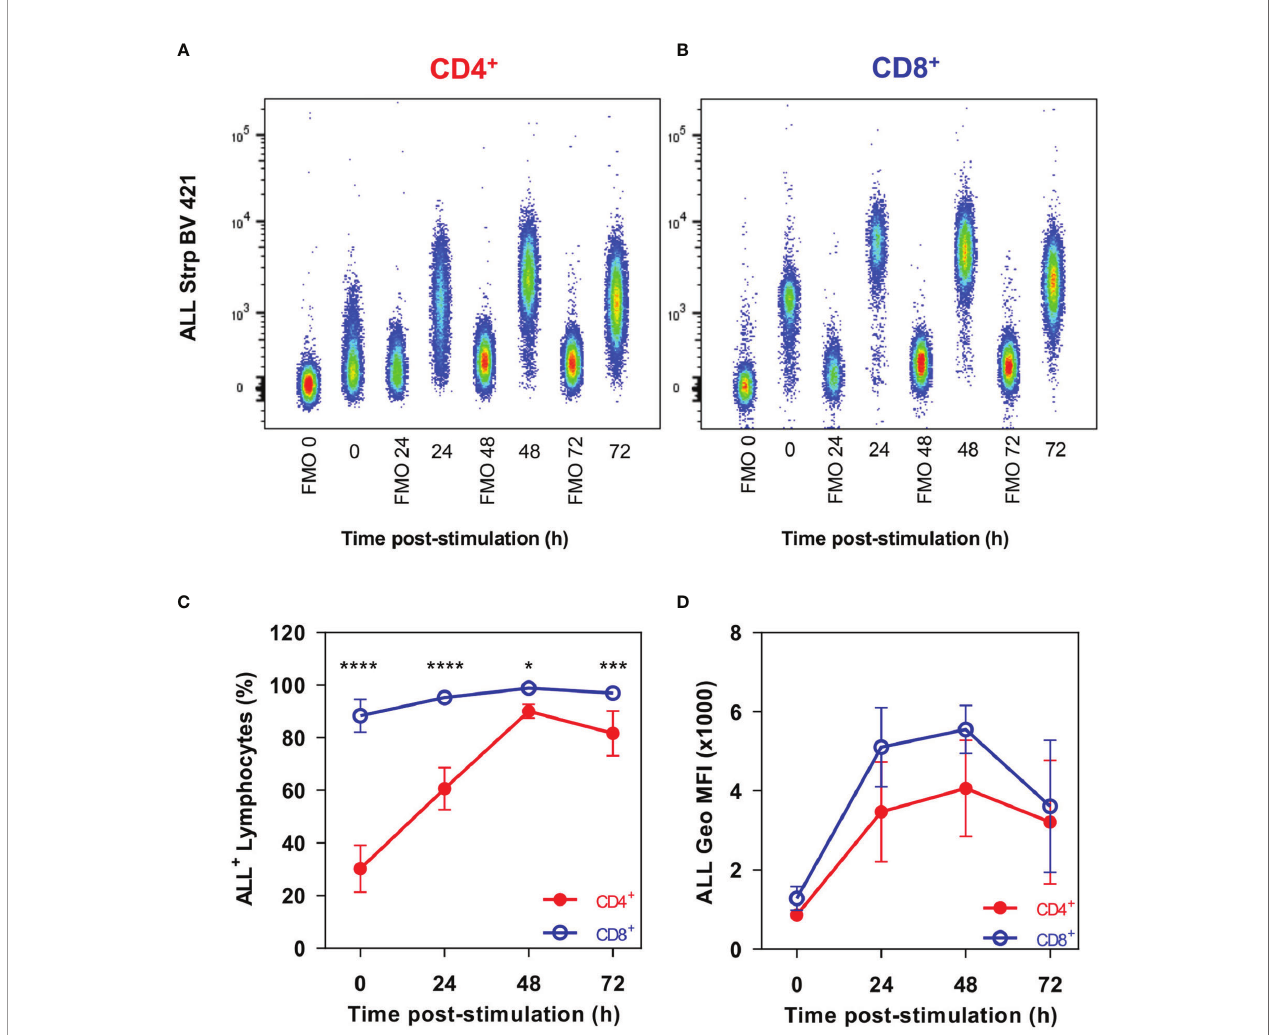
FIGURE 1 | CD4 + and CD8 + T cells show different gpALL expression patterns. Splenocytes were stimulated with anti-CD3 and anti-CD28 mAbs; cells were harvested at the indicated time points and stained with anti-CD4, anti-CD8, ALL, Ghost Dye Red 780, and immediately analyzed in the fl ow cytometer. Lymphocytes were de fi ned by FCS and SSC characteristics, after singlets selection, dead cells were excluded and gpALL were analyzed within CD4 + CD8 - and CD4 - CD8 + sub gates. Representative analysis of gpALL expression kinetics in (A) CD4 + and (B) CD8 + T cells; (C) percentages of CD4 + ALL + and CD8 + ALL + cells and (D) ALL binding in each cell subset after activation. Mean and SD from 2 independent experiments with 3 mice per group are depicted in C and D; data were analyzed using one-way ANOVA followed by Bonferroni ’ s multiple comparison test between CD4 + (Red full circles) and CD8 + (Blue open circles) at each time point. *p < 0.05, ***p < 0.0005, ****p <